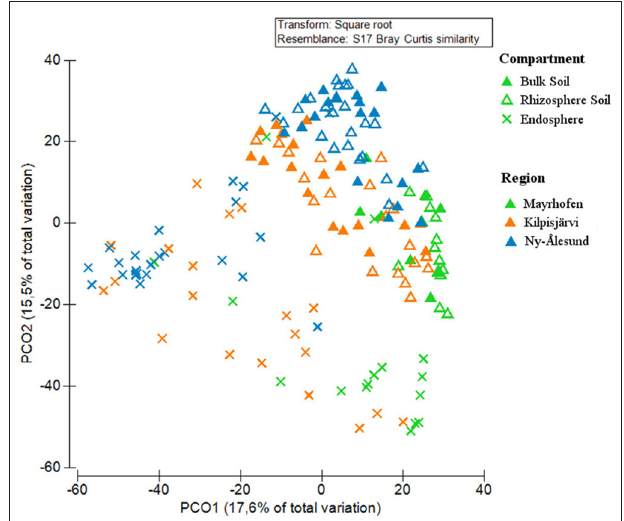
FIGURE 4 | Principal Coordinate Analysis (PCoA) of PNFB communities, from bulk soils, rhizosphere soils, and endospheres of Oxyria digyna and Saxifraga oppositifolia from three regions, based on Bray-Curtis similarity matrix of square root transformed relative abundances of nifH- based OPUs. Symbol shapes correspond to different compartments, and symbol colors to different